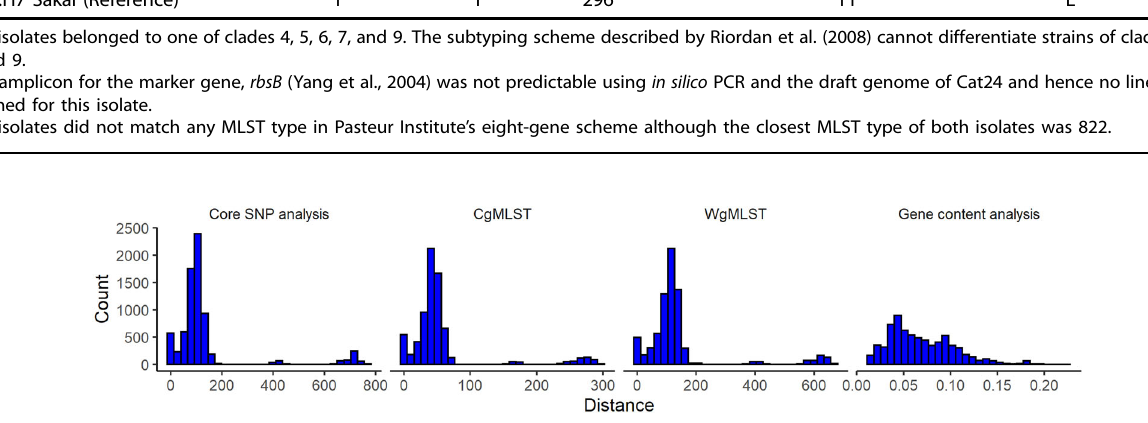
Fig. 1 Distribution of genetic distance for E. coli O157:H7 ( n = 121) isolated from pigs, cattle, and pork production environment. The distance was calculated from core SNP analysis (SNPs), cgMLST (allelic distance), wgMLST (allelic distance), and gene content analysis